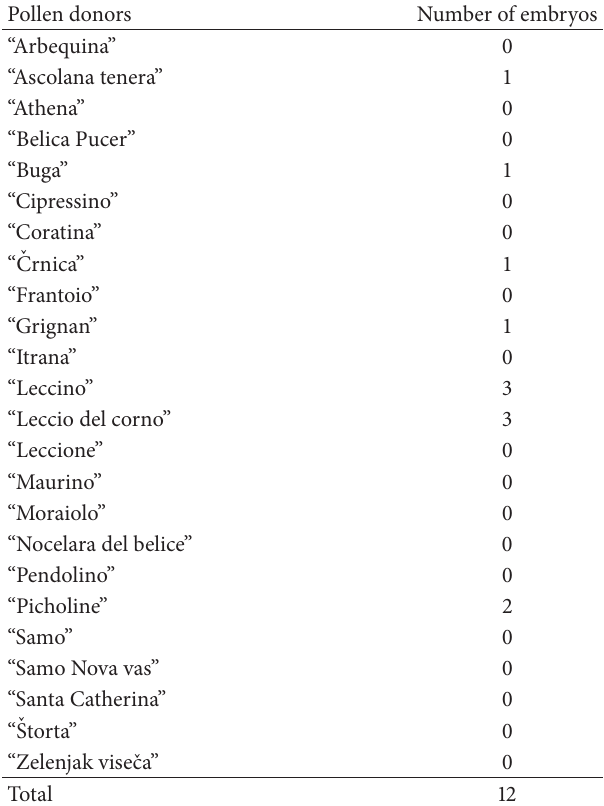
Table 4: Number of embryos assigned to putative pollen donors in “Istrska